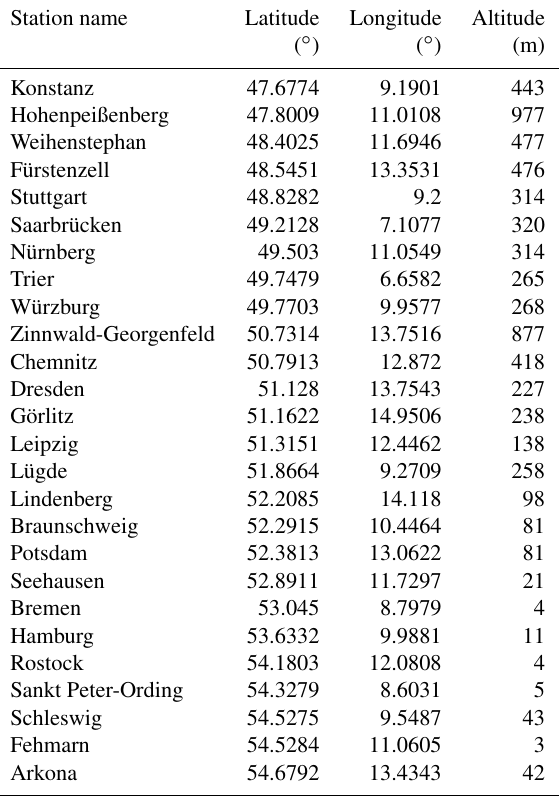
Table 1. Coordinates and altitudes of the 26 stations.